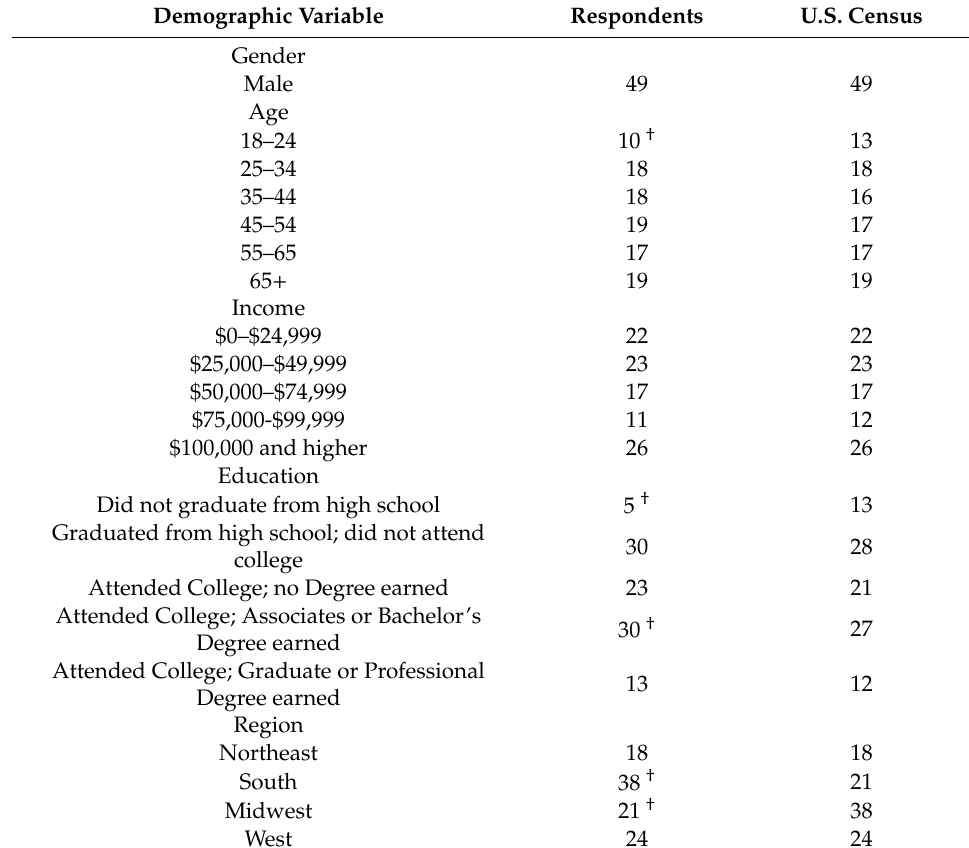
Table 1. Survey demographics (n = 1000), percent (%) of respondents.